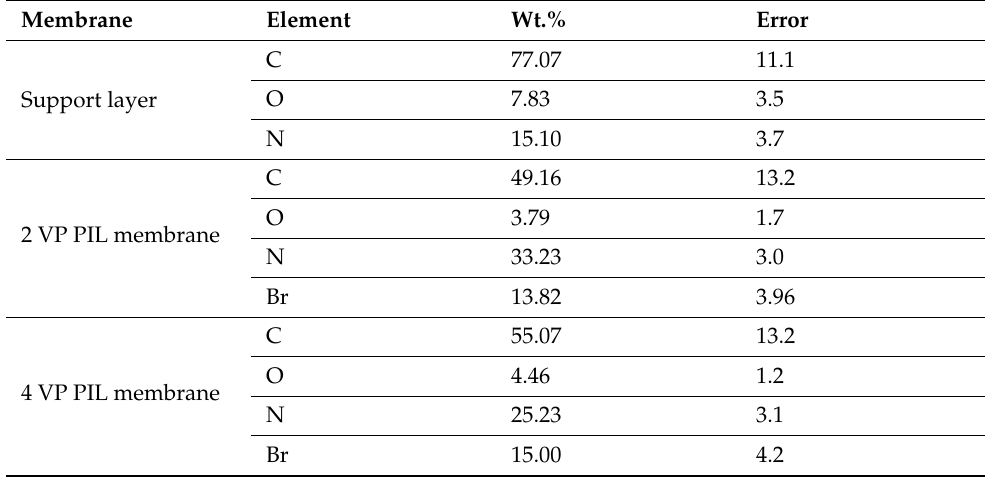
Figure 7. SEM Images of ( a ) Polyamide support layer; ( b ) Membranes obtained from poly(2-Vinyl pridinium bromide) aug- mentation; ( c ) Membranes obtained from poly(4-Vinyl pridinium bromide) augmentation; ( d , f ) AFM image for membrane obtained from poly(2-Vinyl pridinium bromide) augmentation; ( e , g ) AFM image for membrane obtained from poly(4-Vinyl pyridinium bromide) augmentation. Table 2. EDX data for polyimide support membrane and PIL augmented